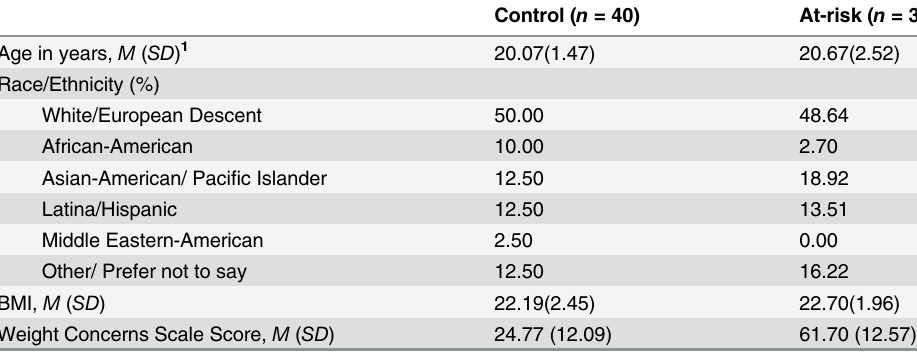
Table 1. Participant demographic and clinical